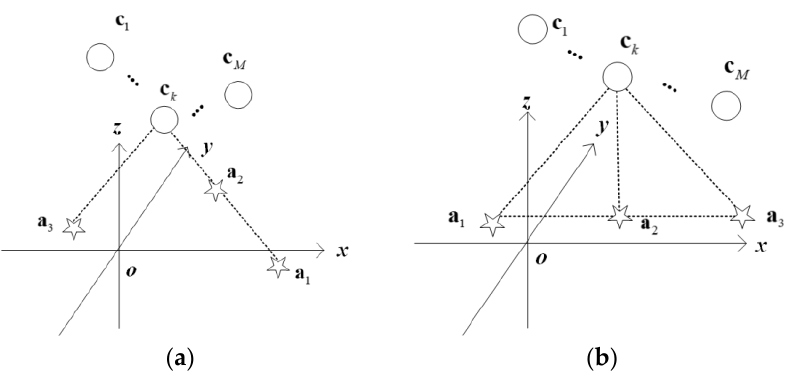
Figure 2. The source geometries ( N = 3) for ( a ) inducing the k th coefficient matrix rank-deficient and ( b ) inducing the singularity of all coefficient matrices.